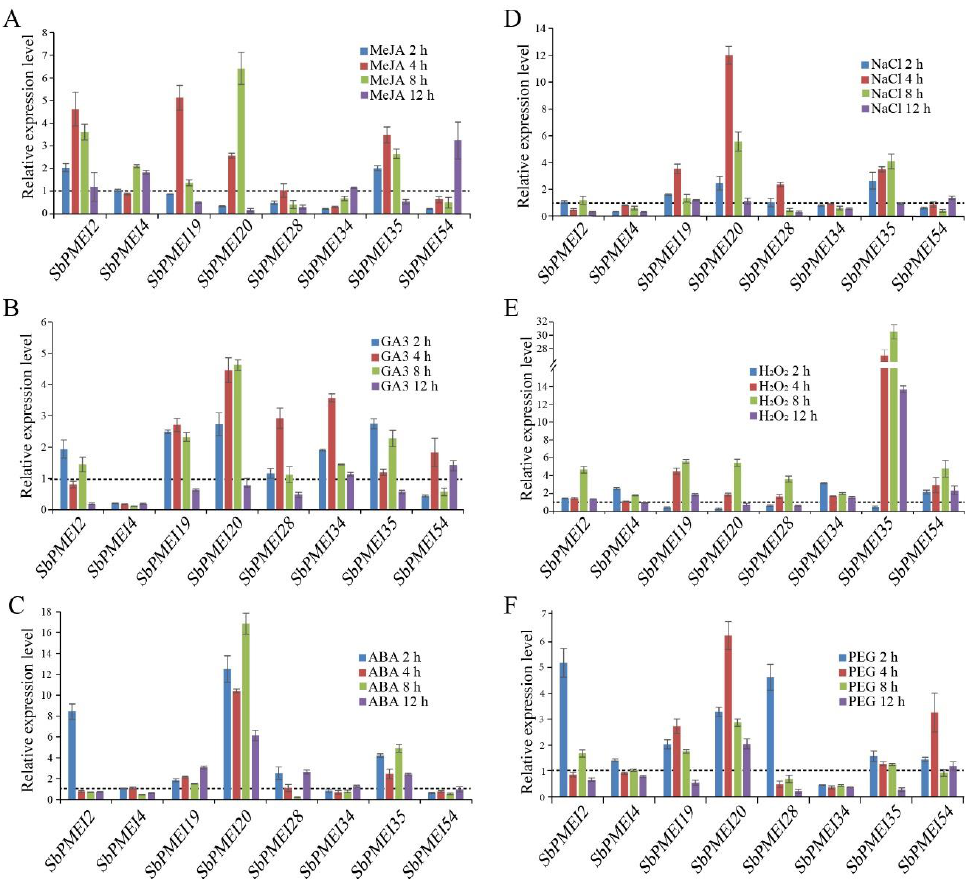
Figure 8. Relative expression levels of eight SbPMEIs involved in three exogenous hormones ( A – C ) and abiotic stresses ( E – F ) using qRT-PCR. Expression patterns treated by: ( A ) 100 μM MeJA; ( B ) 100 μM gibberellin A3; ( C ) 100 μM of abscisic acid; ( D ) 250 mM NaCl; ( E ) 100 mM hydrogen peroxide and ( F ) 25% (w/v) polyethylene glycol. The relative expression level of eleven SbPMEIs were calculated relative to treatment at 0 h.